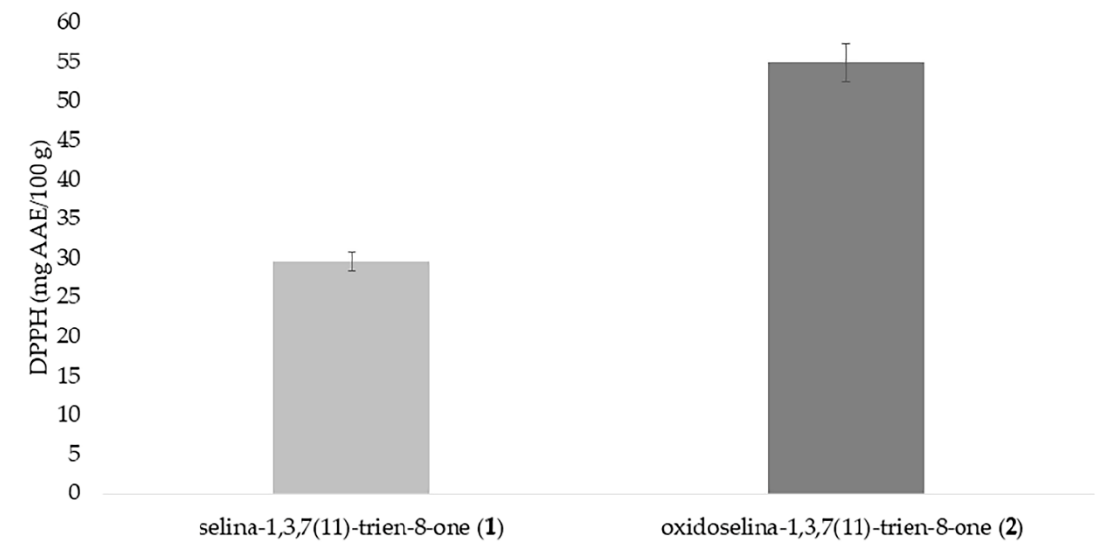
Figure 2. Antioxidant activity of compounds 1 and 2 in mg of ascorbic acid equivalent (AAE) per 100 g of material (AAE/100 g) as measured by the DPPH assay.